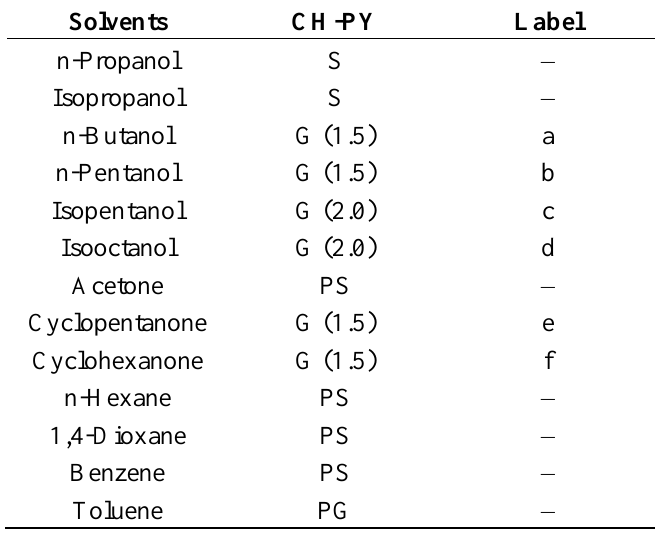
Table 1. Gelation behaviors bolaform cholesteryl compound CH-PY at room